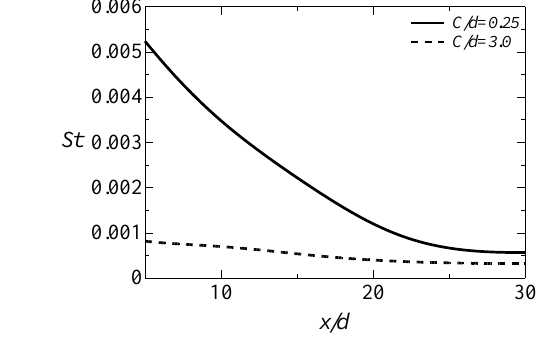
Fig. 7 Distribution of Stanton number.